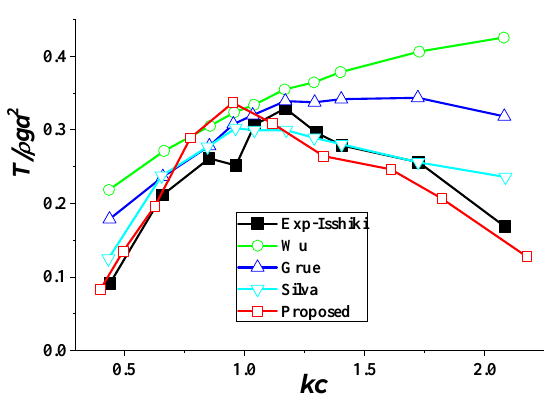
Figure 5. Comparison of non-dimensional thrust in experiment and theory.